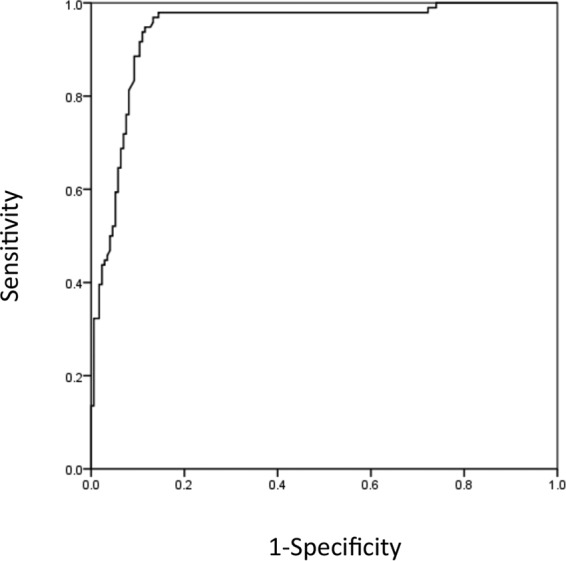
ROC analysis for diagnosing probable and proven cases. The optimal cutoff value of Aspergillus IgG for diagnosing proven and probable cases was 50 mgA/liter (AUC, 0.94; 95% confidence interval, 0.912 to 0.972; sensitivity, 0.98; specificity, 0.84).